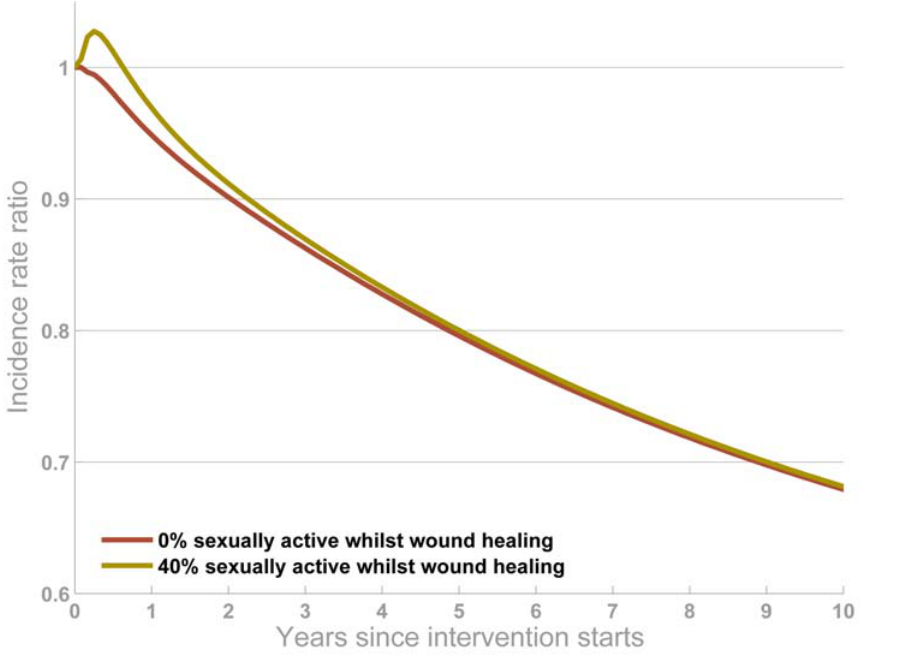
Figure 7. The impact of the wound healing period and circumcising infected men. The projections show the impact of a circumcision intervention with 90% of men being circumcised if it is assumed that the chance of transmission from circumcised men to women is twice as high during the two-month healing period, and 0% of circumcised men (red line) or 40% of men (yellow line) are sexually active whilst the wound heals (yellow line). The output is the ratio of HIV incidence when the intervention is simulated relative to the projection with no intervention.